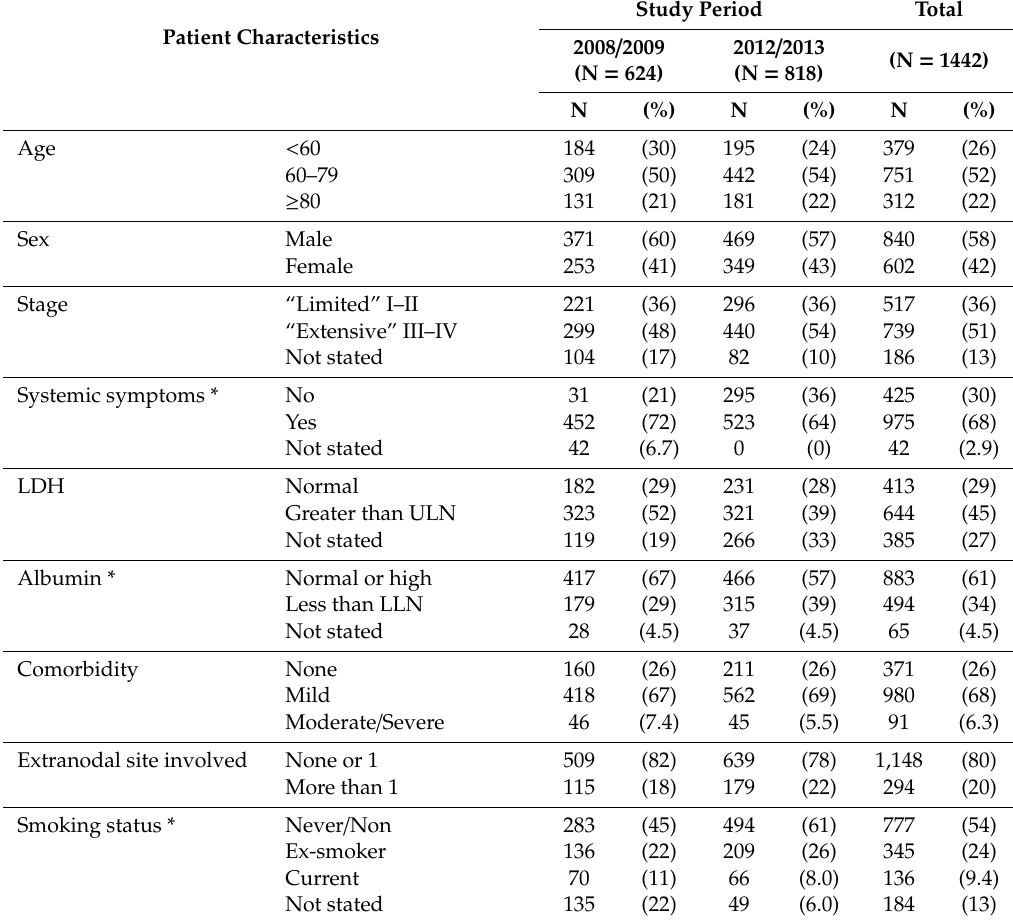
Table 1. Demographics and clinical features of study participants overall and across the two study